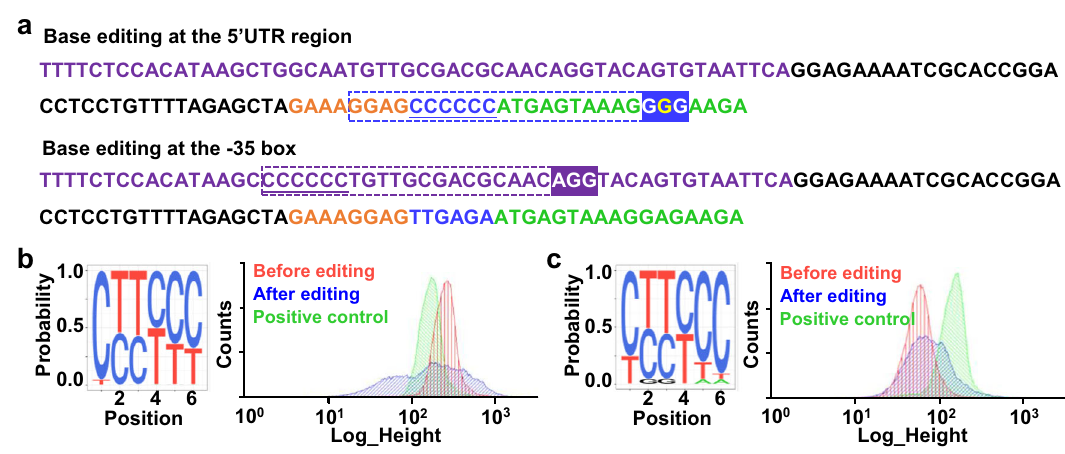
Fig. 3 Reprogramming lycopene biosynthesis by BETTER. a Lycopene biosynthesis pathway and three arti fi cial clusters equipped with constitutive promoters and tailored GGGGGGGG RBSs. Ten target genes are highlighted in red. CDP-ME 4-diphosphocytidyl-2-C-methyl- D -erythritol, CDP-MEP 4- diphosphocytidyl-2C-methyl- D -erythritol-2-phosphate, DMAPP dimethylallyl diphosphate, FPP farnesyl diphosphate, GGPP geranylgeranyl pyrophosphate, HMBPP ( E )-4-hydroxy-3-methylbut-2-enyl-diphosphate, IPP isopentenyl diphosphate, MEC 2C-methyl- D -erythritol-2,4-cyclodiphosphate, MEP 2-C- methyl- D -erythritol-4-phosphate. b Schematic illustration of two sets of double-gRNAs combinations and corresponding editing windows. The two Gs shaded in green are covered by two editing windows (blue and orange). c Components of RBS libraries of dxs gene generated by BETTER with the two sets of double-gRNAs combinations. Merged represents the sum of RBS variants generated by the aforementioned two editing events. Three colonies were used for base editing and the cells were mixed with an equal proportion before extraction of genomic DNAs, PCR ampli fi cation, and NGS. d Discreteness change of genetic combinations of RBS ispE generated by BETTER with the two sets of double-gRNAs combinations. KL divergence was used to evaluate the discreteness of genetic combinations. e The matrixes show the coverage and discreteness of 256 G/A-containing RBS ispE variants in the RBS libraries generated by BETTER with the two sets of double-gRNAs combinations. Scale bar represents log 2 (relative proportion). f Screening lycopene overproduction cells from the libraries generated by BETTER. g Lycopene production and RBS strength assay of the ancestral strain (strain 0) and four screened strains with intense red pigmentation (strains 1-4). RBS strength was determined using a chromosomal GFP reporter. Scale bar represents GFP fl uorescence normalized with OD fl ect the mean ± s.d. of three biological replicates ( n = 3). Statistical evaluation ( P value) 600 nm . Values and error bars re of the comparison between each screened strain and the ancestral strain was performed by a two-sided t test. *** P < 0.001, n = 3. Source data underlying Fig. 3d, e, g are provided as a Source Data fi le.